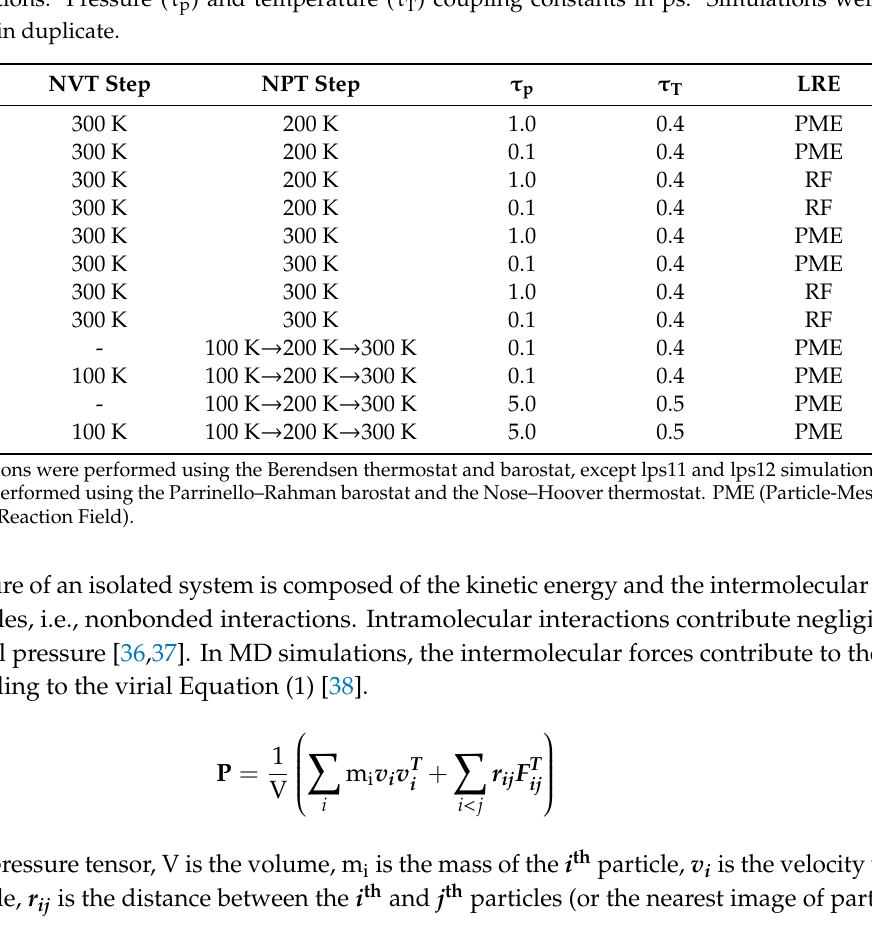
bars. Simulations performed at 200 K and 300 K are shown in circles and triangles, respectively. The inset shows pressure averages at the first step of the NPT phase for direct comparison. ( c ) Representative configuration of the LPS / DPPE bilayer with the largest value of volume per lipid (dotted black triangles). Only water molecules inside the hydrophobic region of the membrane are shown and near clipping of LPS molecules was applied to improve visualization. Ca 2 + is shown in green and oxygen and hydrogen in water molecules are in red and white, respectively. Symbols correspond to lps1 (dotted black circles), lps2 (filled black circles), lps3 (dotted red circles), lps4 (filled red circles), lps5 (dotted black triangles), lps6 (filled black triangles), lps7 (dotted red triangles), and lps8 (filled red triangles).